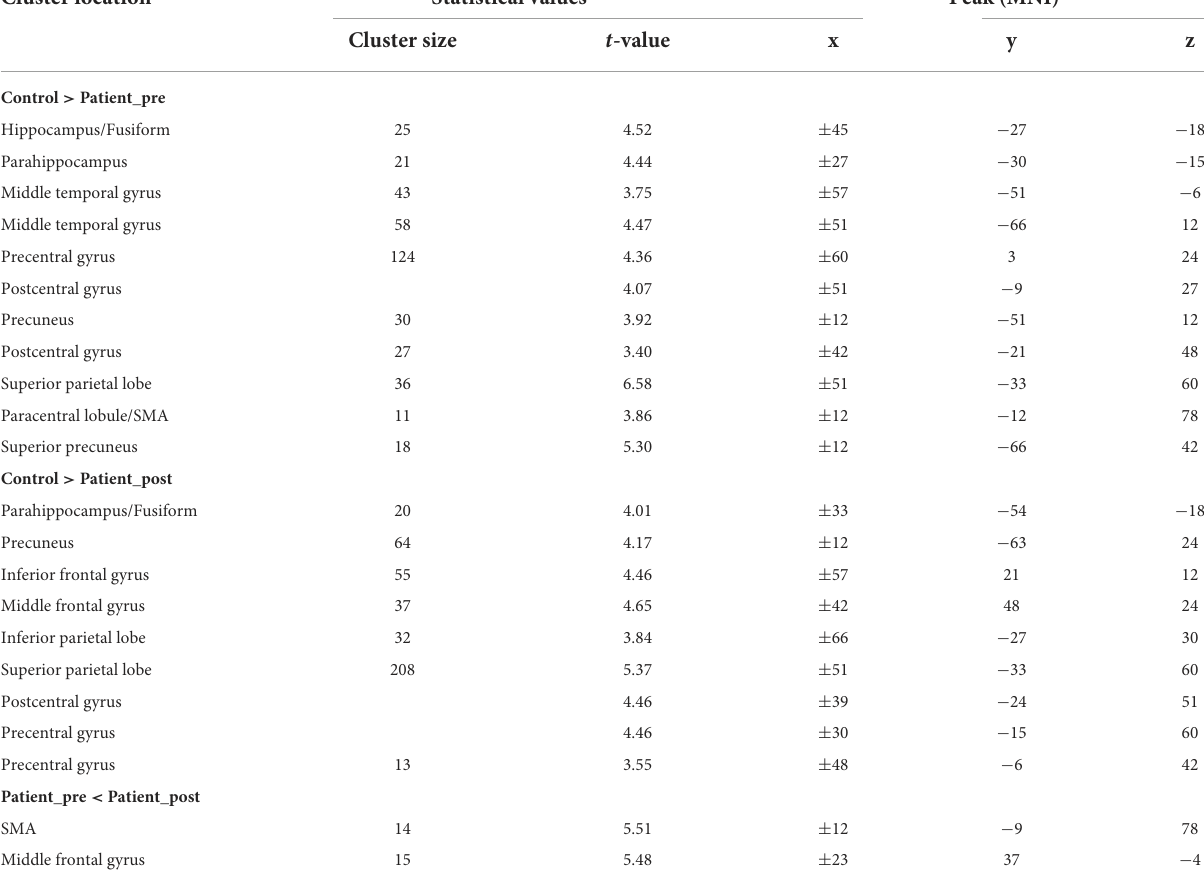
TABLE 2 Significant group differences in